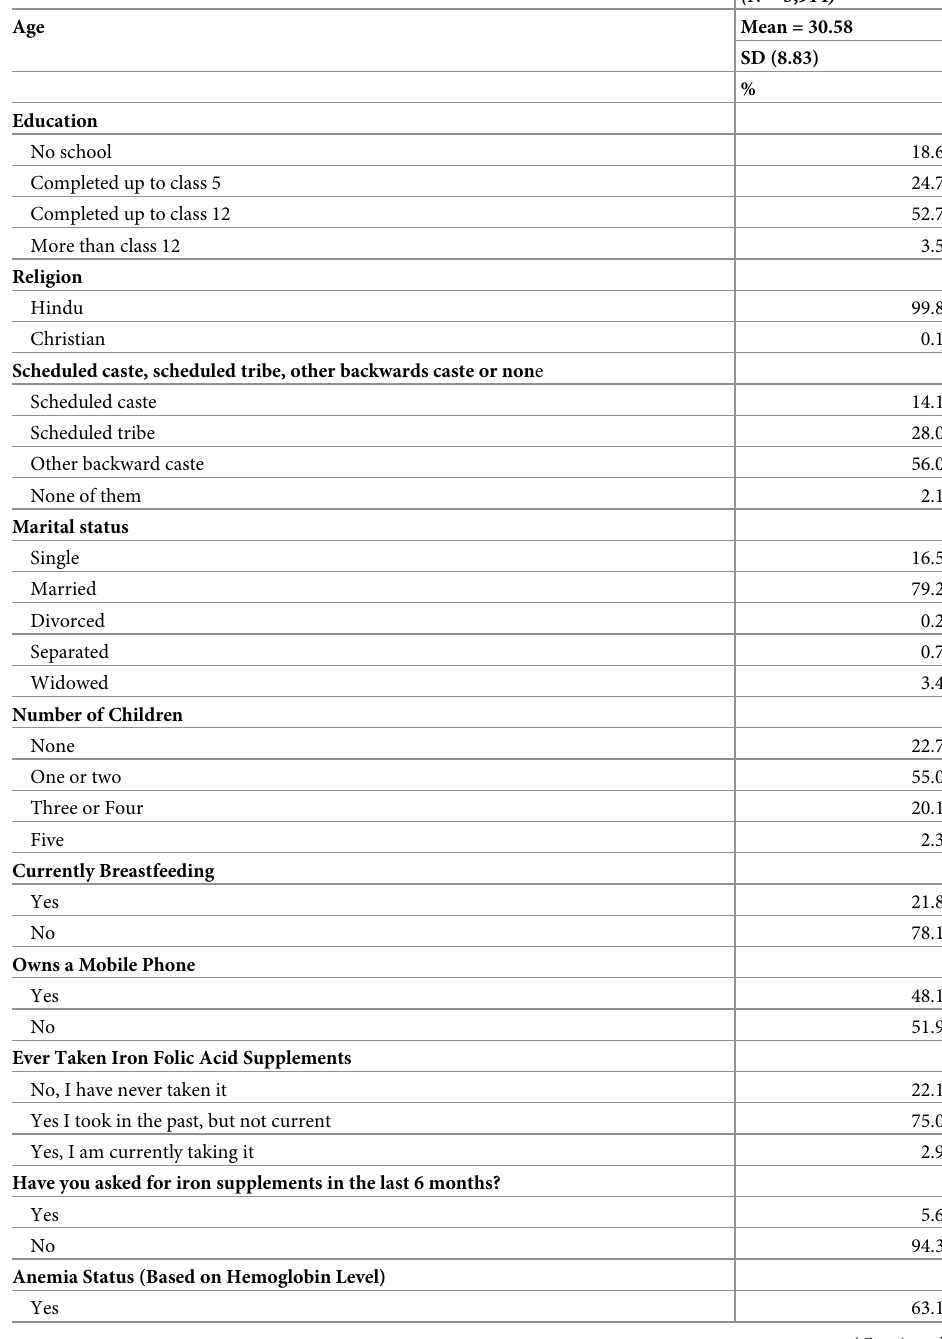
Table 1. Description of the